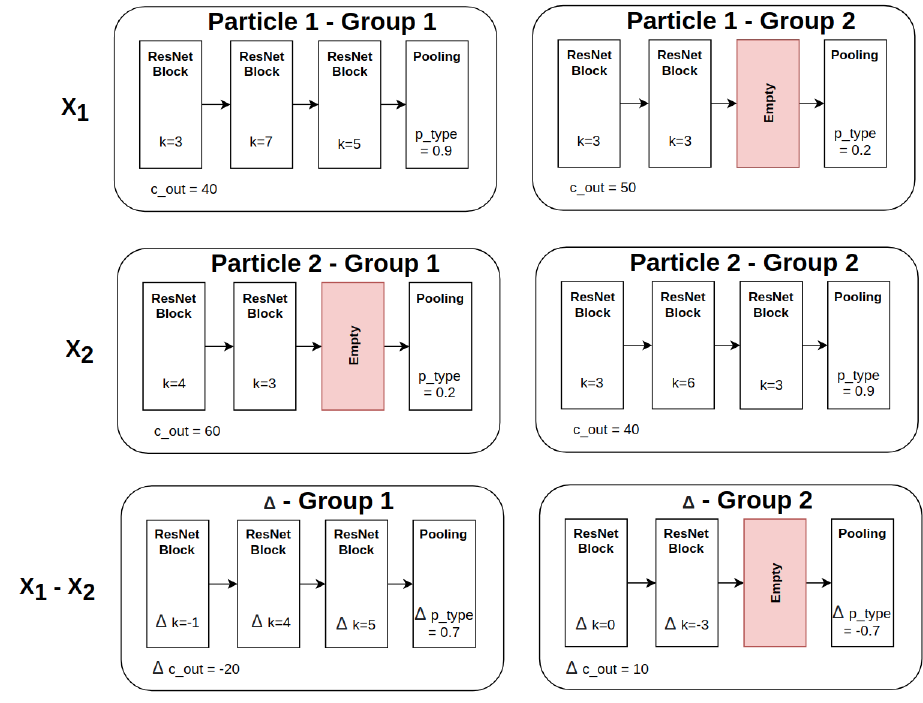
Figure 5. An example particle difference computation for X 1 − X 2